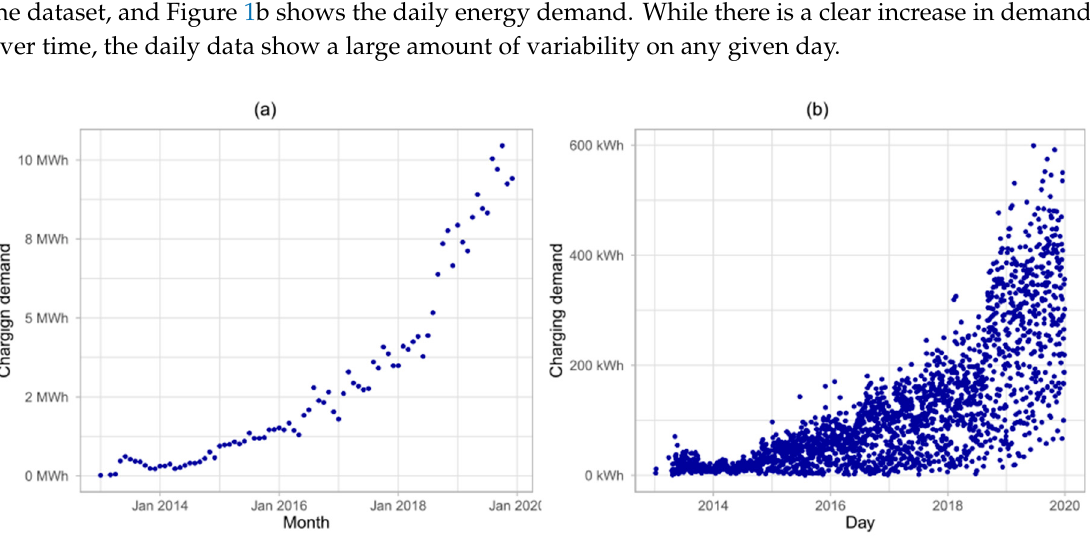
Figure 2. Charging demand for every session.